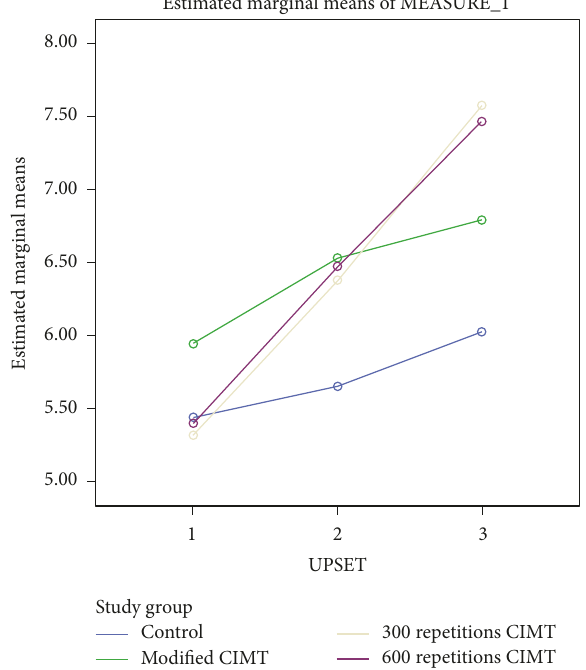
Figure 6: A profile plot showing groups’ mean scores in UPSET at baseline, 2 weeks, and 4 weeks after